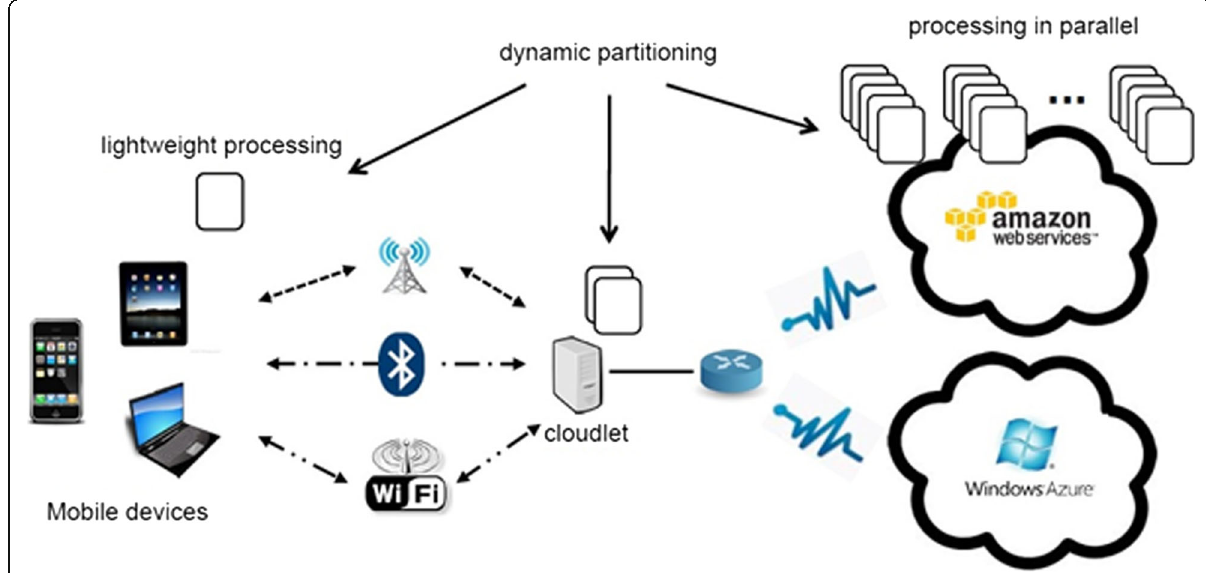
Fig. 1 The MOCHA Architecture: mobile devices interact with the cloudlet and the cloud via multiple connections and use dynamic partitioning to achieve their quality of service. Goals (e.g., latency, cost)